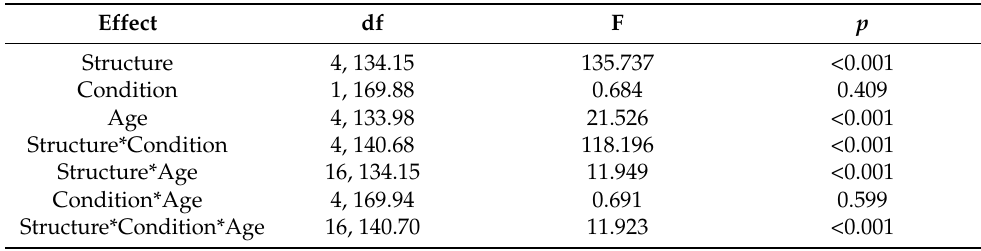
Table 4. Summary of the fixed factors in the mixed effects log-linear model for participants’ produc-